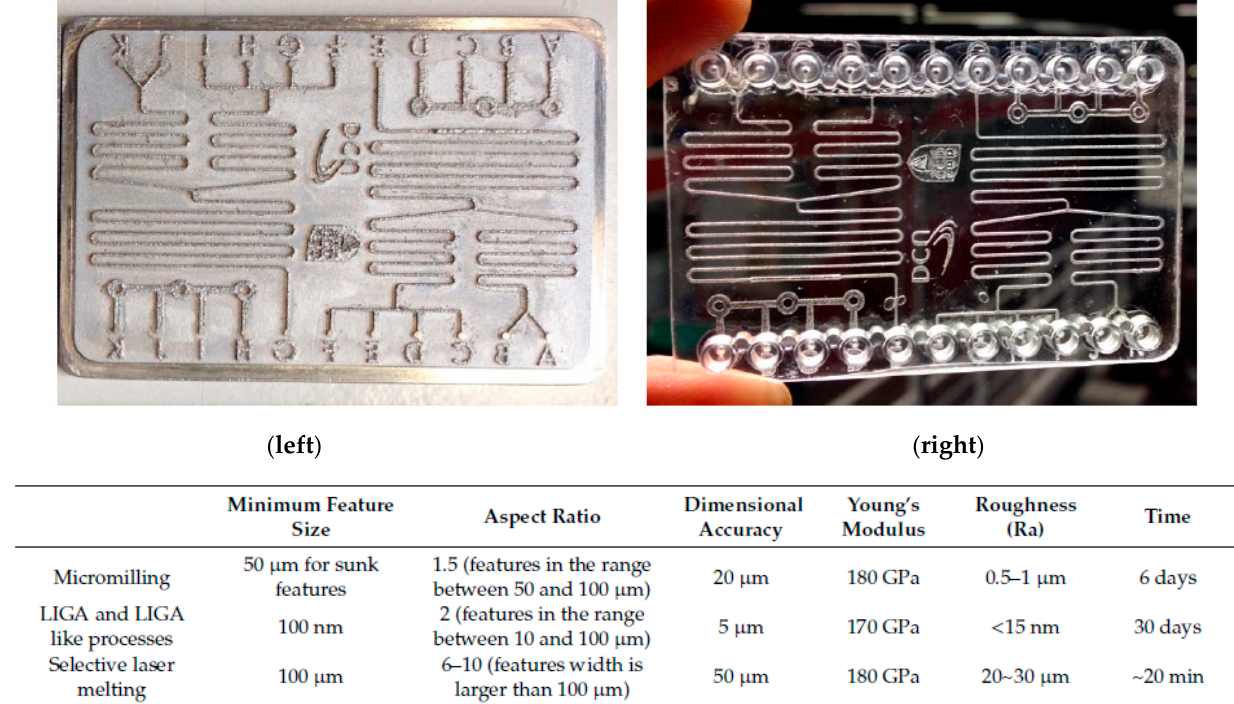
Figure 23. Micro-patterns printed on steel substrate using SLM ( left ) and polymeric micro-fluidic chip after micro-injection molding ( right ) along with a comparison of other micro-fabrication processes with SLM ( bottom ) [60].